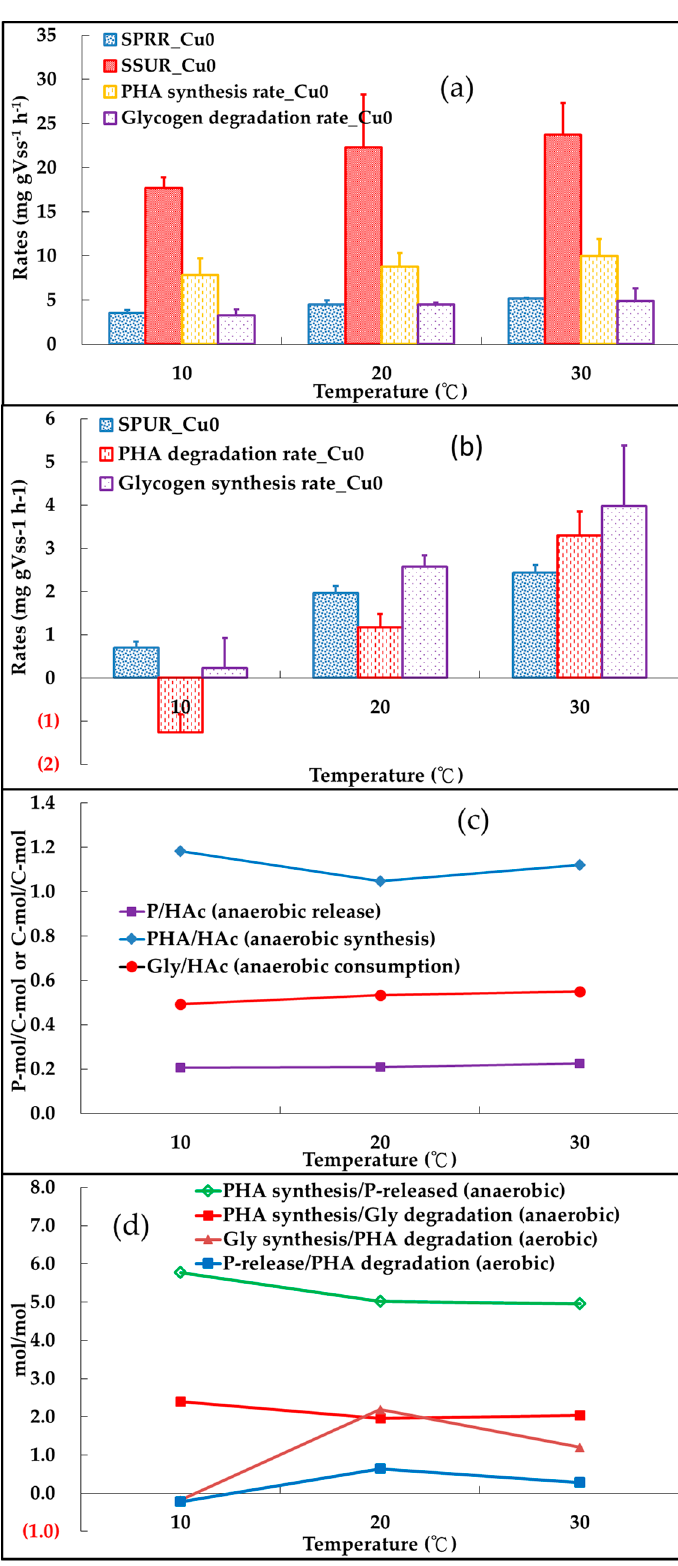
Figure 1. Relations between temperature and ( a ) the anaerobic metabolic rates; ( b ) the aerobic metabolic rate; ( c ) ratios of P-release/acetate (HAc), glycogen (Gly)/HAc, and polyhydroxyalkanoate (PHA)/HAc; ( d ) PHA synthesis/P-released, PHA synthesis/Gly degradation, Gly synthesis/PHA degradation, and P-release/PHA degradation.